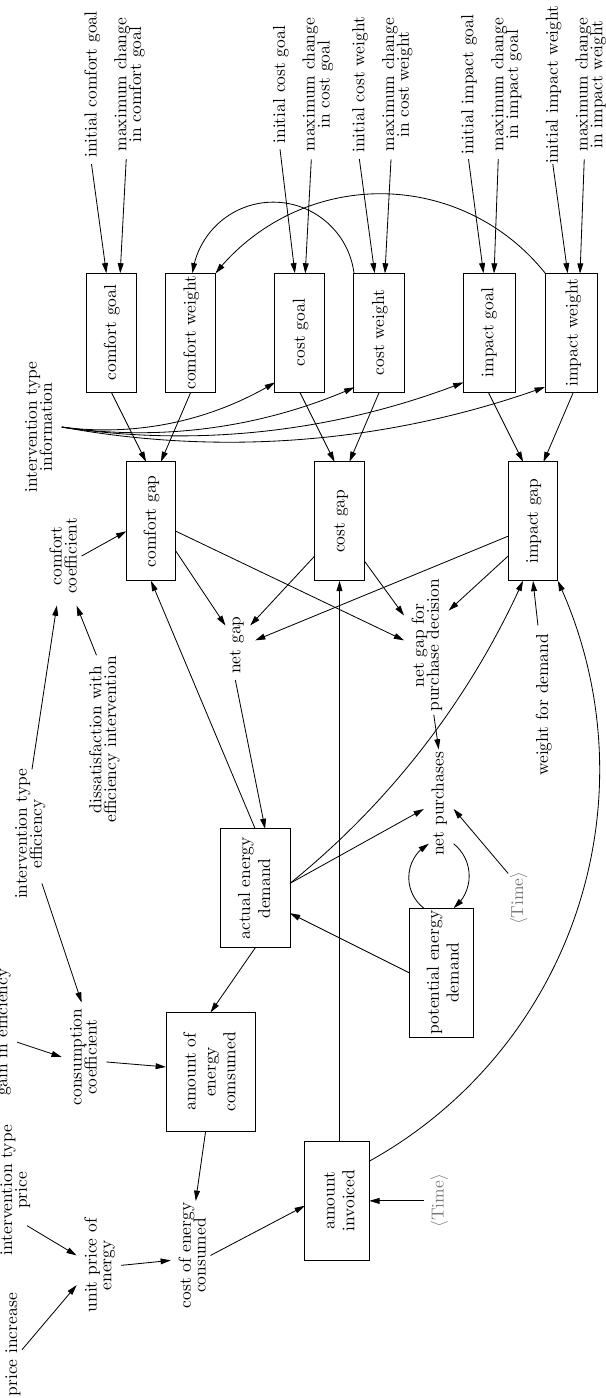
Figure 1: System dynamics model of household energy